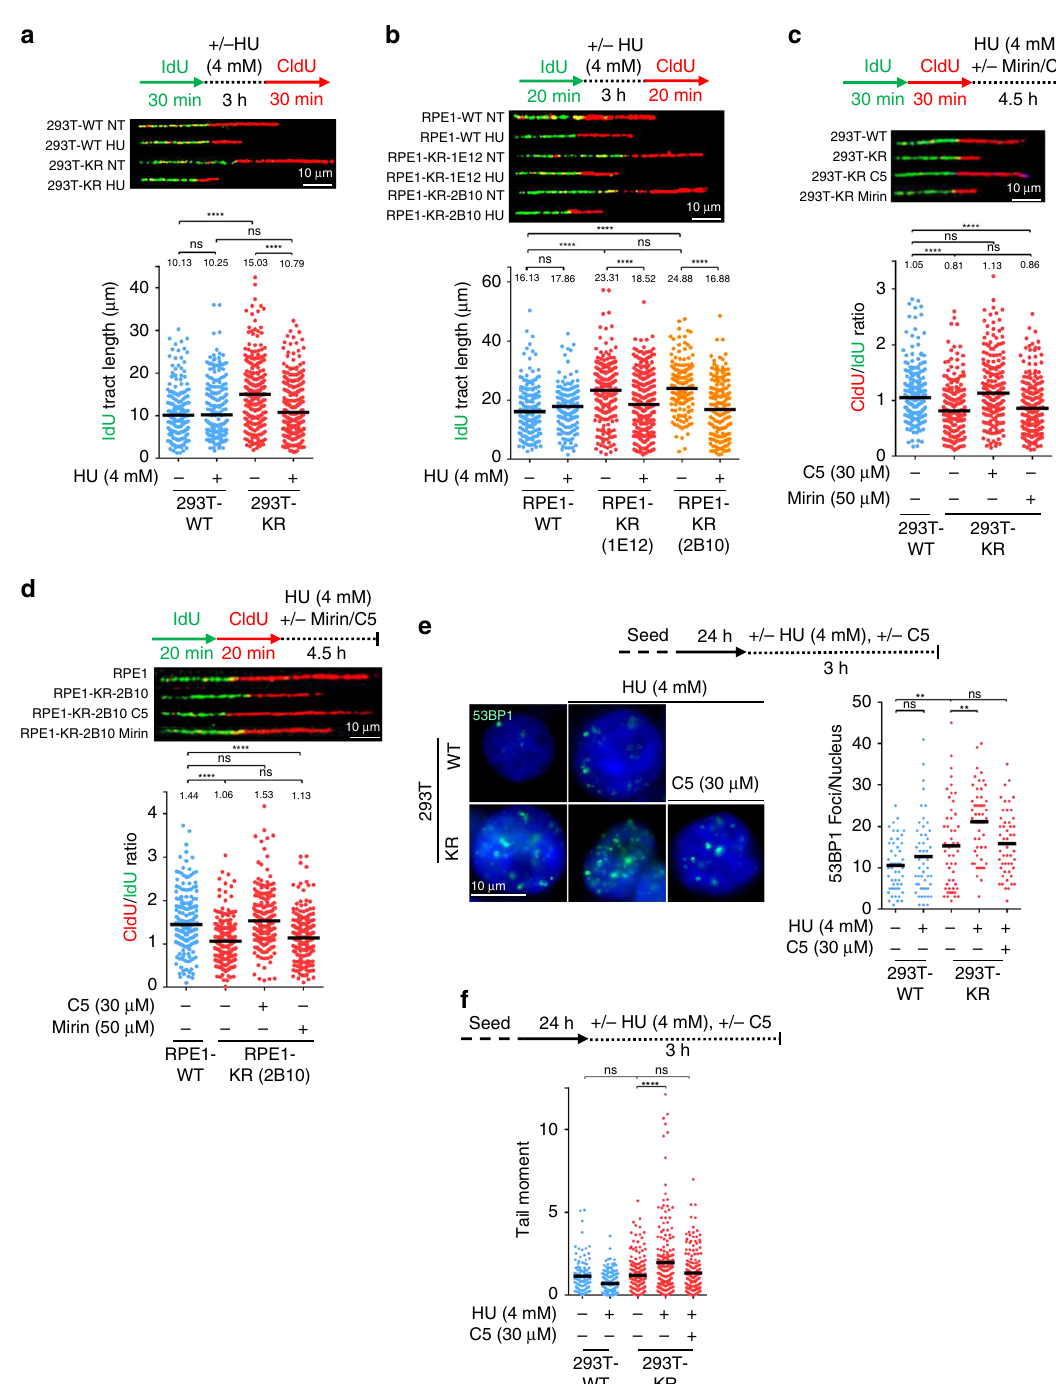
Fig. 2 PCNA-K164R cells exhibit DNA2-mediated nascent DNA degradation. a , b DNA fi ber combing assays showing faster replication fork progression in 293T-K164R cells a and two different clones of RPE1-K164R cells b under normal growth conditions, and nascent strand degradation upon HU treatment. The quanti fi cation of the IdU tract length is presented, with the median values marked on the graph and listed at the top. Asterisks indicate statistical signi fi cance (Mann – Whitney test, two-sided). Schematic representation of the assay conditions, and representative micrographs are also presented. c , d HU-induced nascent strand degradation in 293T-K164R c and RPE1-K164R d cells is suppressed by incubation with the DNA2 inhibitor C5, but not by treatment with the MRE11 inhibitor mirin. The ratio of CldU to IdU tract lengths is presented, with the median values marked on the graph and listed at the top. Asterisks indicate statistical signi fi cance (Mann – Whitney test, two-sided). A schematic representation of the assay conditions, as well as representative micrographs are also presented. e Immuno fl uorescence experiment showing that HU treatment augments 53BP1 foci formation in unsynchronized 293T-K164R cells. DNA2 inhibition suppresses 53BP1 foci formation in KR cells. At least 50 cells were quanti fi ed for each condition. The mean values are marked on the graph, and asterisks indicate statistical signi fi cance ( t -test, two-tailed, unequal variance). Representative micrographs are also shown. f Neutral comet assay showing that 293T-K164R cells accumulate DSBs upon HU treatment. DNA2 inhibition suppresses this accumulation. At least 100 cells were quanti fi ed for each condition. The mean values are marked on the graph, and asterisks indicate statistical signi fi cance ( t -test, two-tailed, unequal variance). Source data are provided as a Source Data fi